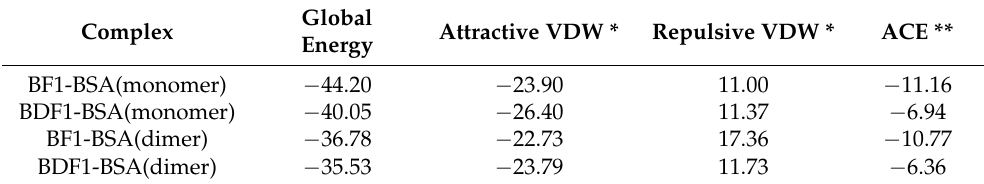
Table 3. Docking results for the best poses of BF1 and BDF1 in complex with BSA. All energies are given as